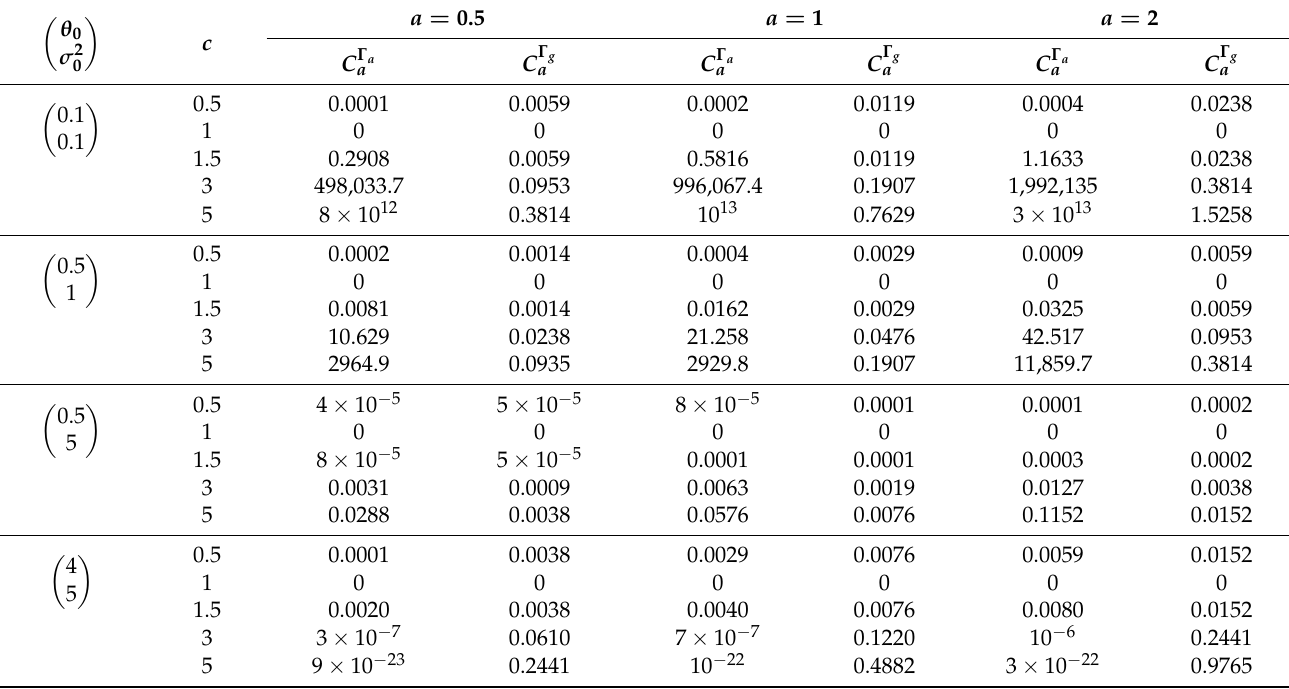
Table 6. Values of the local curvature for two classes Γ a and Γ g for a sample generated from